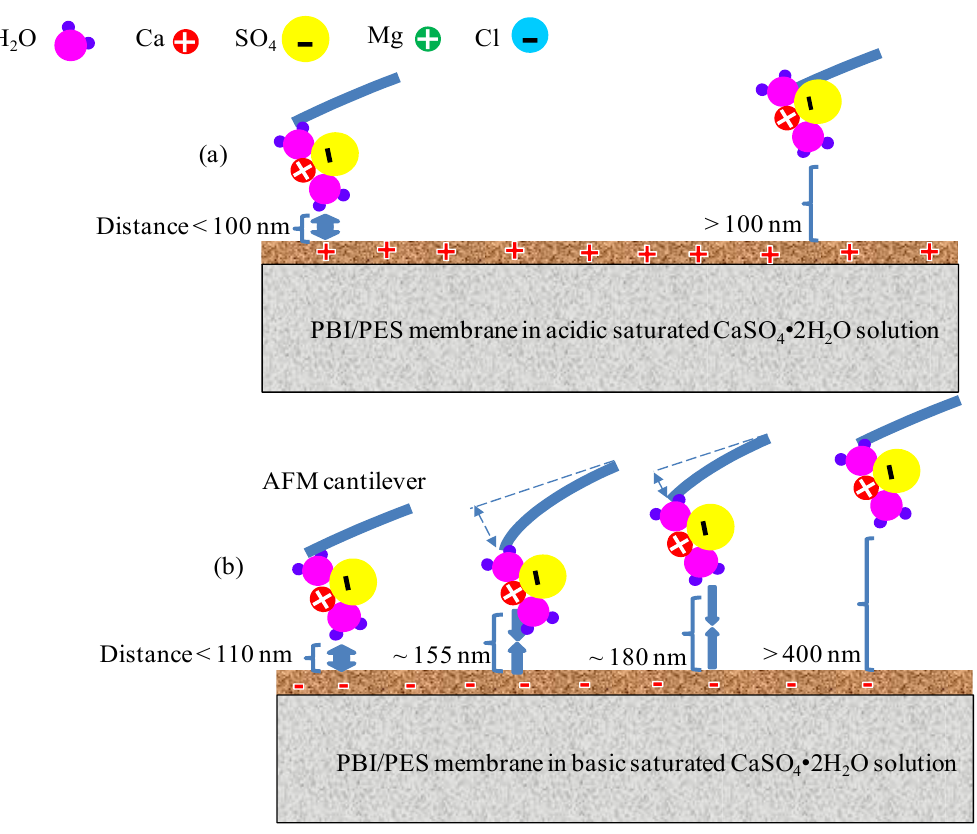
Figure 11. A schematic diagram of molecular interactions between the PBI/PES membrane and gypsum. ( a ) In acidic solutions, strong repulsive force exists at a distance ( i.e. , distance between the PBI/PES membrane and gypsum) smaller than 100 nm; no attractive force can be observed; ( b ) In basic solutions, attractive force appears when the distance is larger than 110 nm (the strongest at 155 nm and the medium at 180 nm); the force disappears when distance is larger than 400